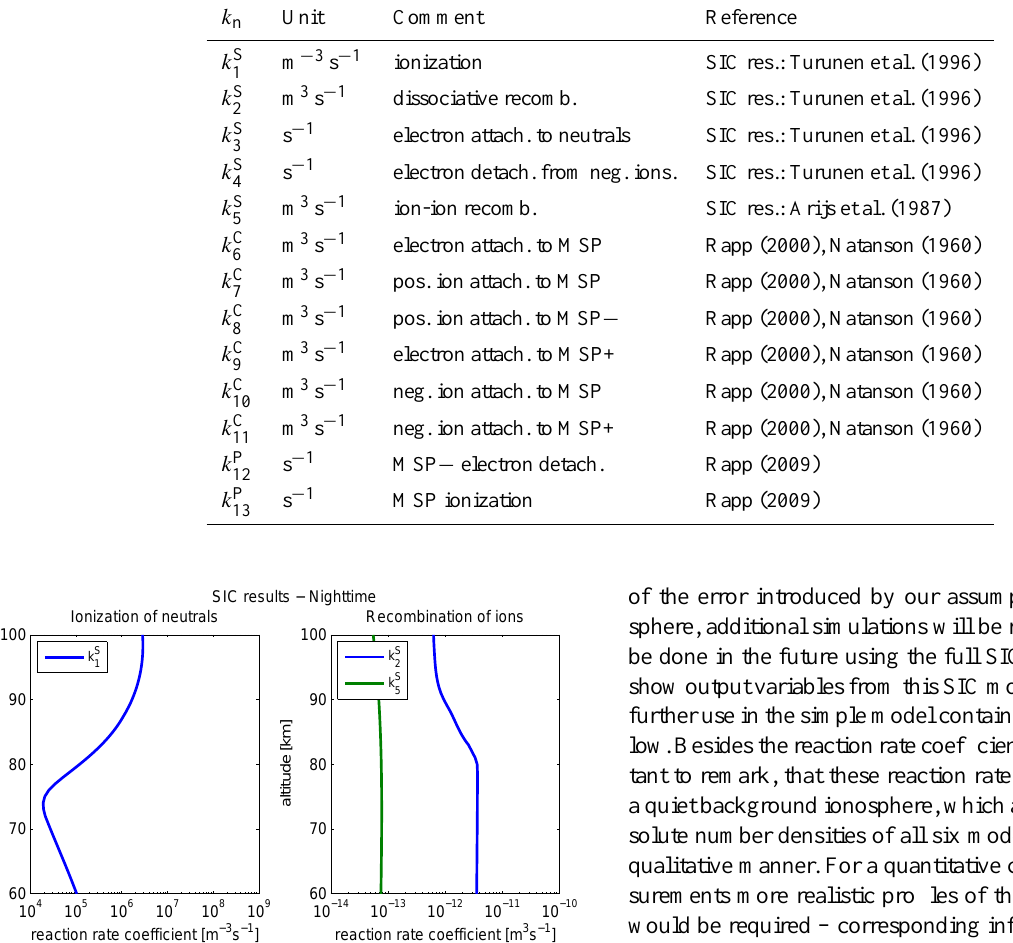
Table 2. Description of the thirteen reaction rate coefficients, their units in the model and reference of their origin.